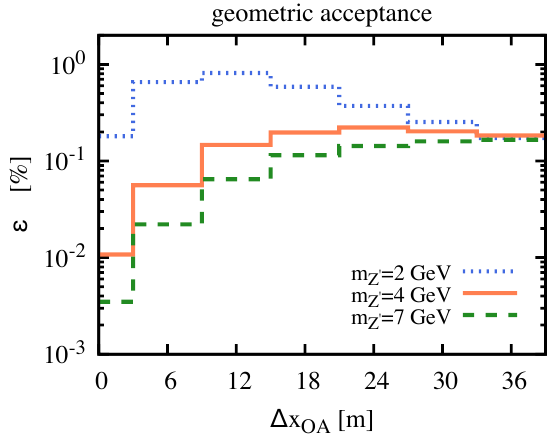
Figure 4 . Geometric acceptance for leptophobic scalar DM particles as a function of the detector location relative to the beam axis. The different colored lines correspond to different masses of the Z 0 mediator. The drop of the acceptance when going towards the on-axis location is a consequence of the scalar nature of the DM